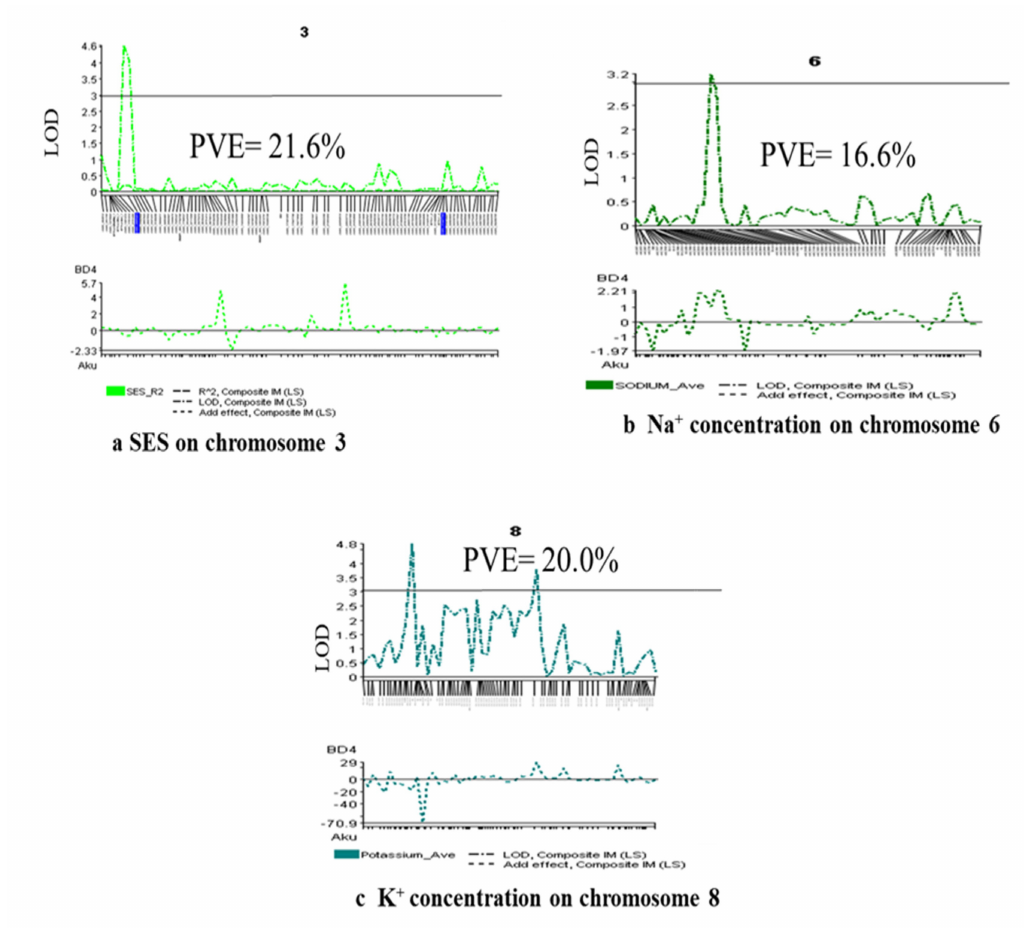
Figure 4. QTL likelihood curves showing the LOD score of ( a ) SES score on chromosome 3, ( b ) Na + concentration on chromosome 6 and ( c ) K + concentration on chromosome 8 were above the signifi- cance threshold of LOD = 3.0 and explained approximately 21.6%, 16.6% and 20.0% of the phenotypic variance for each